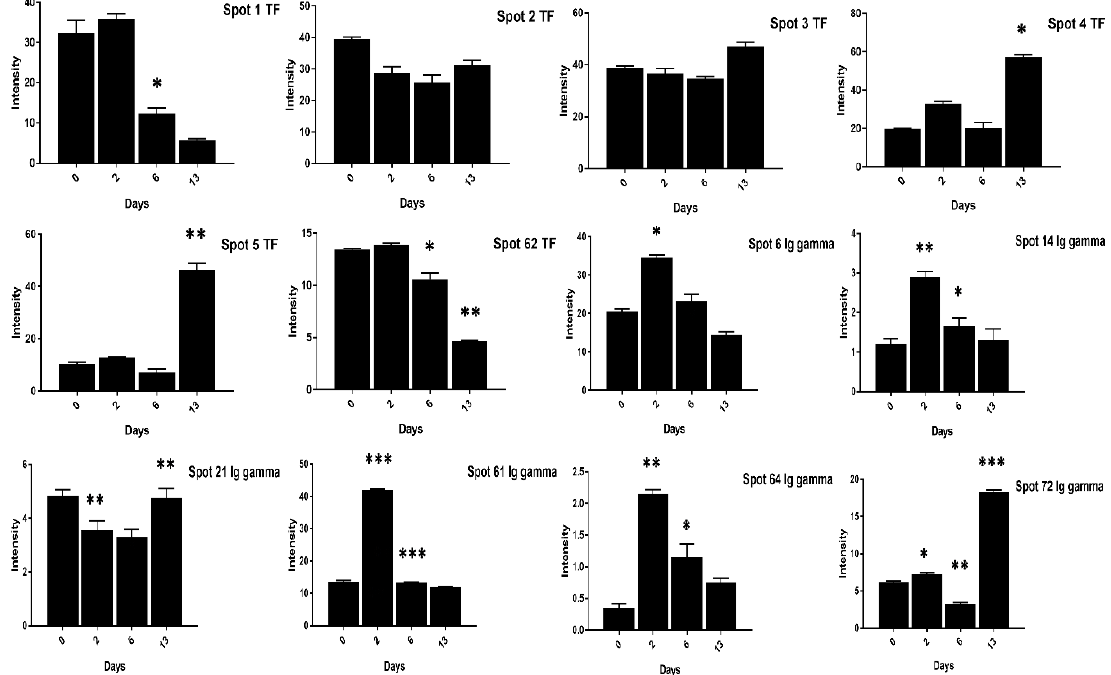
Figure 7. Differential expression of TF and Ig gamma proteins after 0, 2, 6, and 13 days of incubation was shown in high cholesterol eggs. The TF spots (1–5, 62), and Ig gamma (6, 14, 21, 61, 64, 72) showed significant differences at different incubation days. The error bars represent the standard deviation. * p < 0.05, ** p < 0.005, *** p < 0.0001.